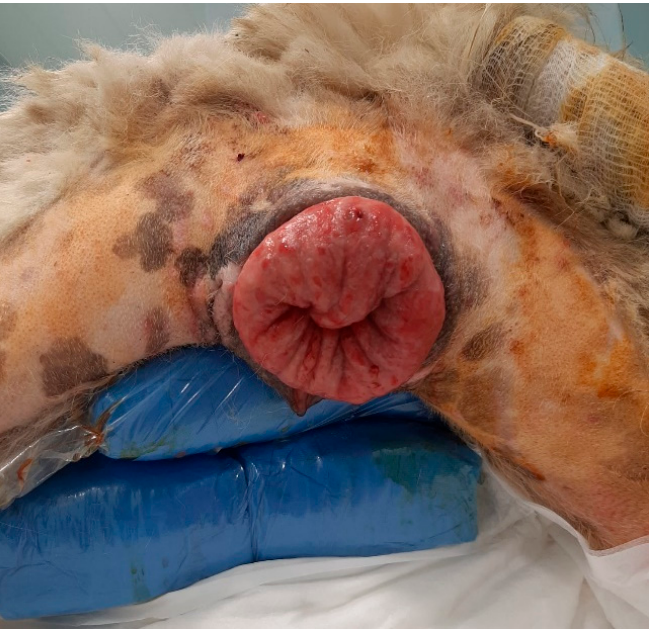
Figure 2 . Patients are positioned in sternal recumbency, with the hindlimbs off the table and a soft thickness below the pelvis. The tail is wrapped and hairs are clipped from the tail to the limbs. The prolapsed tissues were cleansed with saline and sprayed abundantly with 50% glucose solution (Glucose S.A.L.F. 50% ®® , S.A.L.F., Cenate Sotto, Italy) to reduce edema. the prolapsed tissues in a physiological condition. A second operator maintained constant pressure to hold repositioned tissues in place. Finally, digital palpation of the vagina ensured complete distension of the